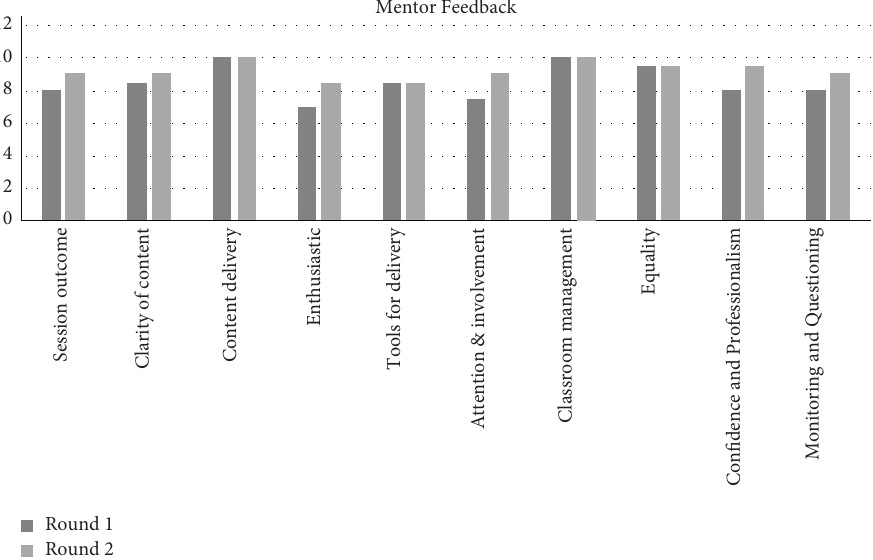
Figure 5: Peer observation by mentor in cycle 1 (dark grey bars) and cycle 2 (light grey